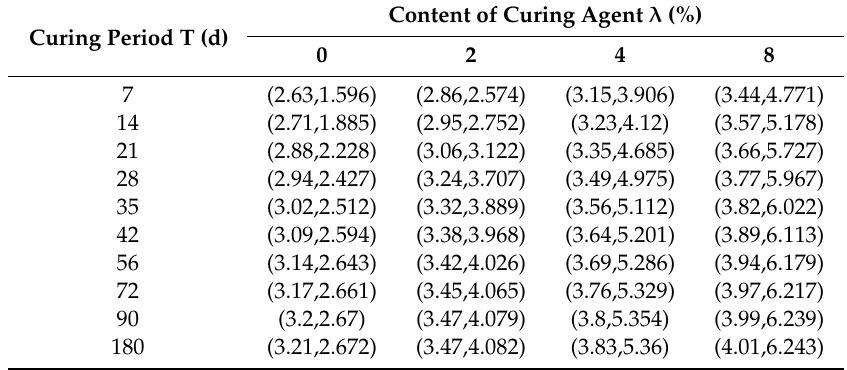
Table 7. The average equivalent particle size ( x -axis) and the compressive strength ( y -axis). Curing Period T